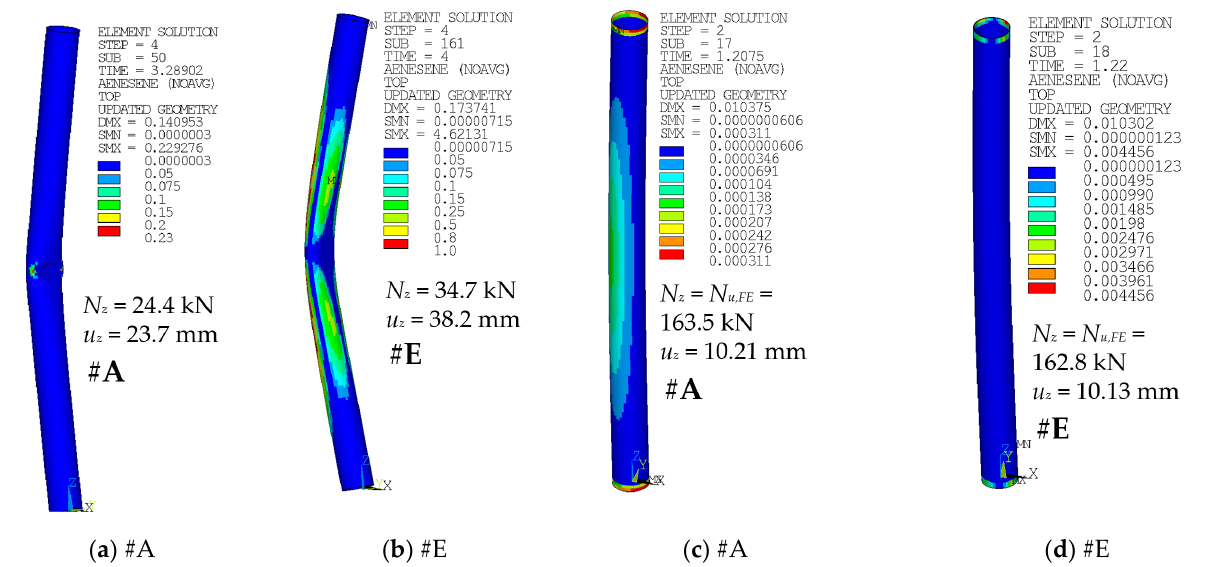
Figure 15. 104 × 2-1650-P (SCP), ratio of artificial to total energy: ( a ) #A, last step; ( b ) #E, last step; ( c ) #A, at peak load; and ( d ) #E, at peak load.